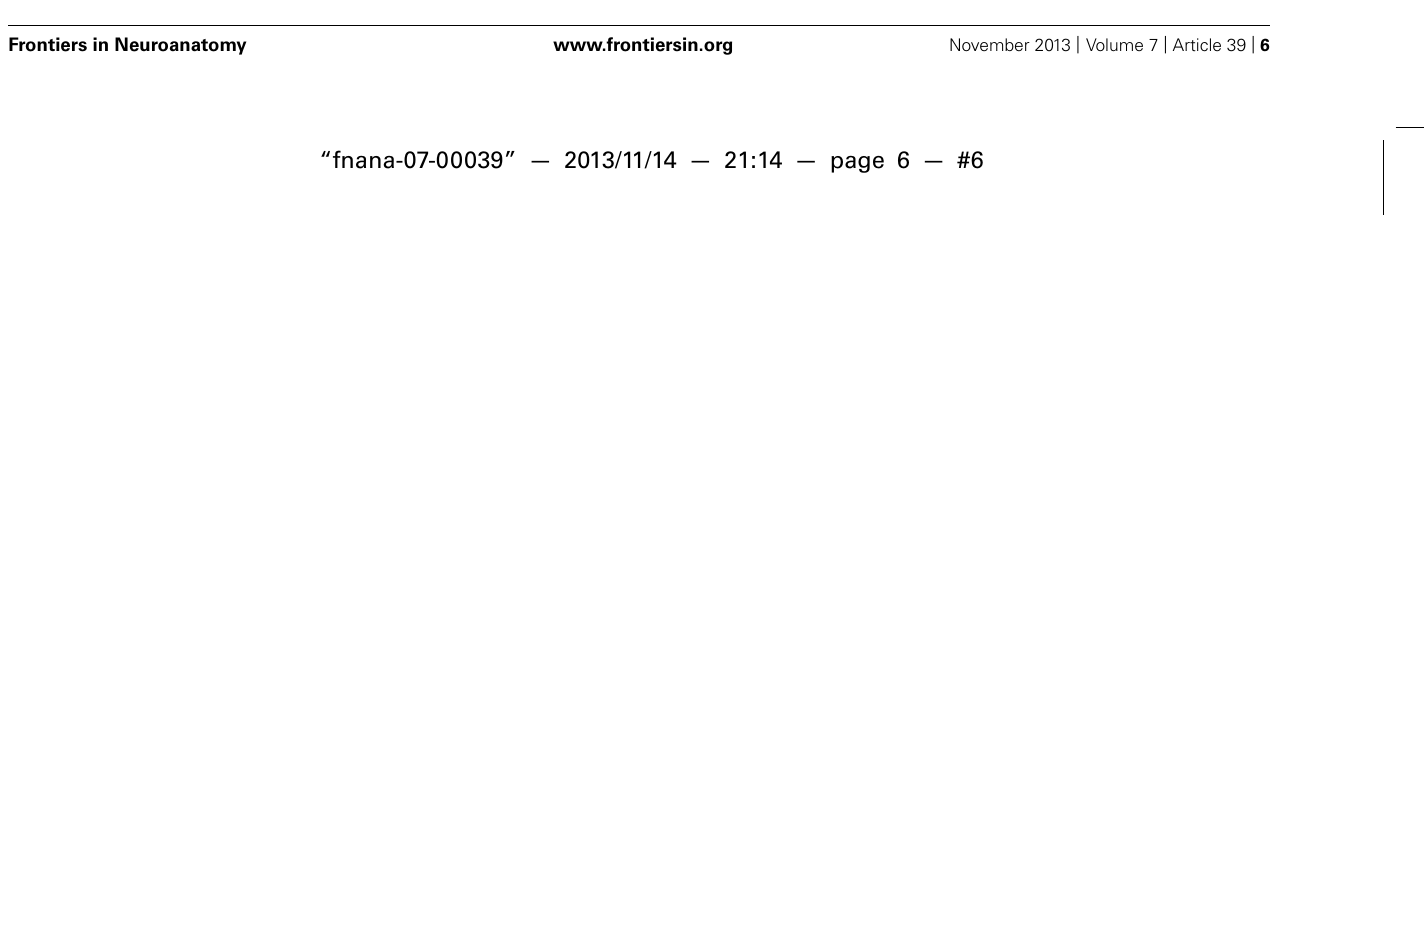
outline recording sites injected with toluidine blue at the termination of the experiment to serve as anatomical landmarks. “X” marks designate recording sites from which no response was detected. (B) Illustration of the naked mole-rat cerebellum with a box delineating the area exposed by craniotomy. Dorsal view, rostral is up. Animal #121409. Scale bars: 1 mm for both (A,B)